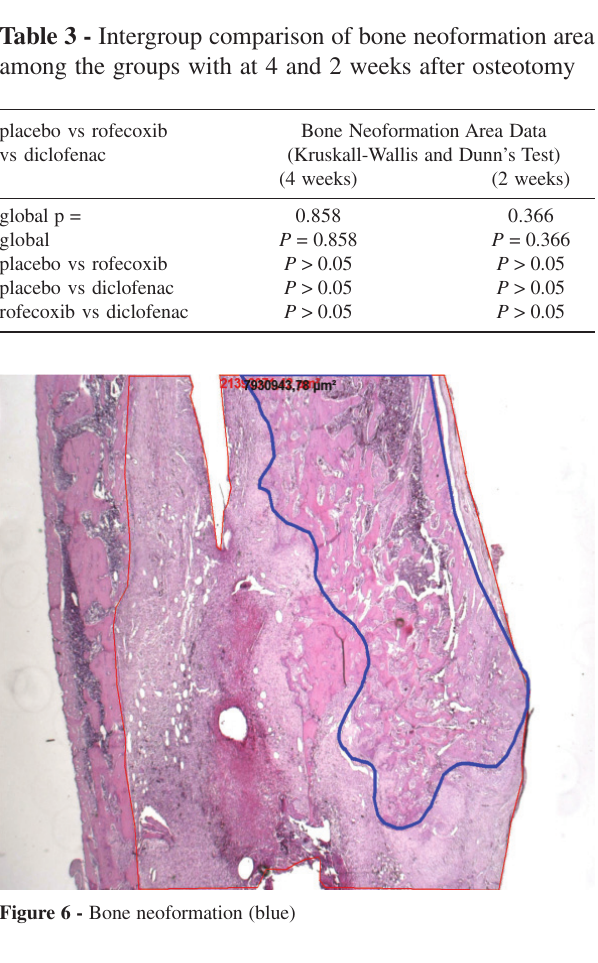
Table 1 - Intergroup comparison of bone callus area among the groups withat 4 and 2 weeks after osteotomy placebo vs rofecoxib Bone Callus Area Data vs diclofenac (Kruskall-Wallis and Dunn’s Test) (4 weeks)